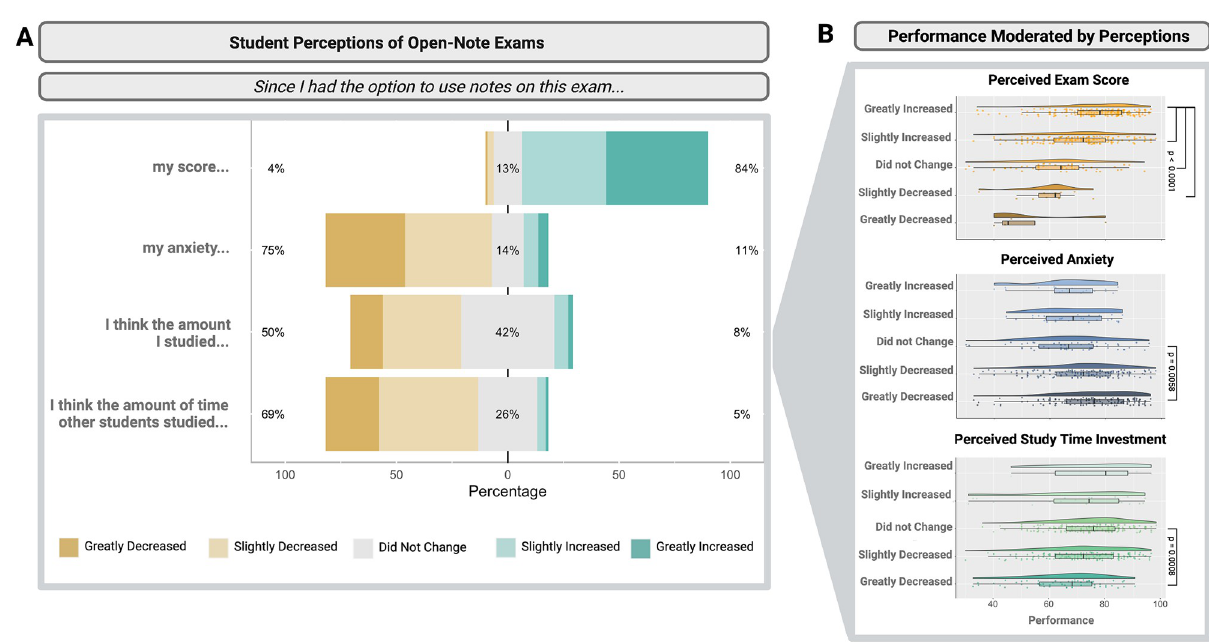
Fig 2. Student perceptions of open-note exams. Students were asked a series of 5-point Likert scale questions. (A) Students report perceptions of increased exam performance, decreased anxiety, decreased personal study time investment, and decreased peer study time investment on open-note exams as compared to closed-note exams. (B) Only students reporting that the ability to use notes on their exam “greatly increased” their exam score, “greatly decreased” their anxiety, or “greatly decreased” their study investment had significant impacts on performance.